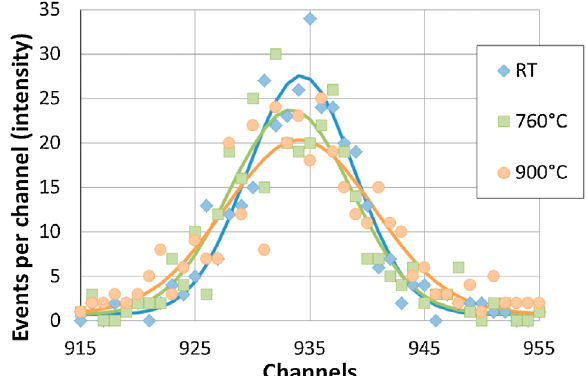
Fig. 7. Gaussian fi tting (solid lines) of the 3 He pro fi les in B 4 C analysed by NRA with deuteron energy of 1300 keV. Samples were annealed over 1 h at different temperatures ( ° C) before the analysis.